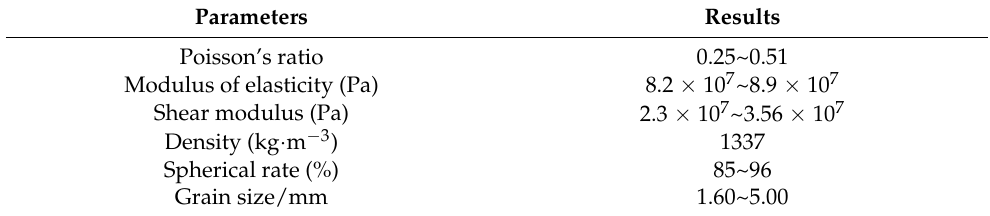
Table 2. Urea particle related